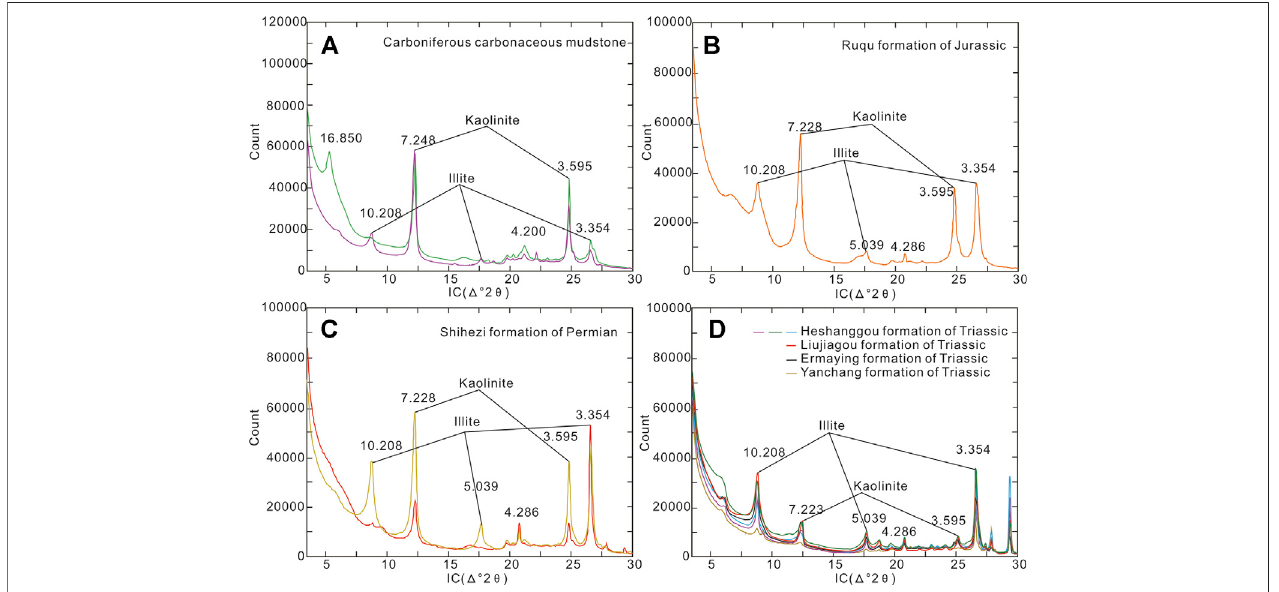
FIGURE 4 | X-ray diffraction of illite in central Qinshui Basin. (A) Carboniferous carbonaceous mudstone. (B) Ruqu formation of Jurassic sample. (C) Shihezi formation of Permian sample. (D) Triassic formation sample.